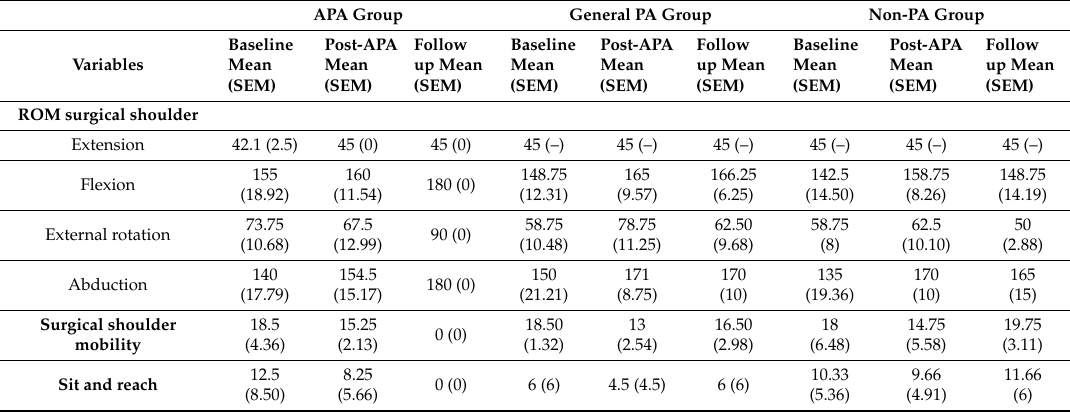
Table 3. Mean scores of fitness tests at baseline, post-APA, and follow up (two years post-APA) for each of the three study groups.